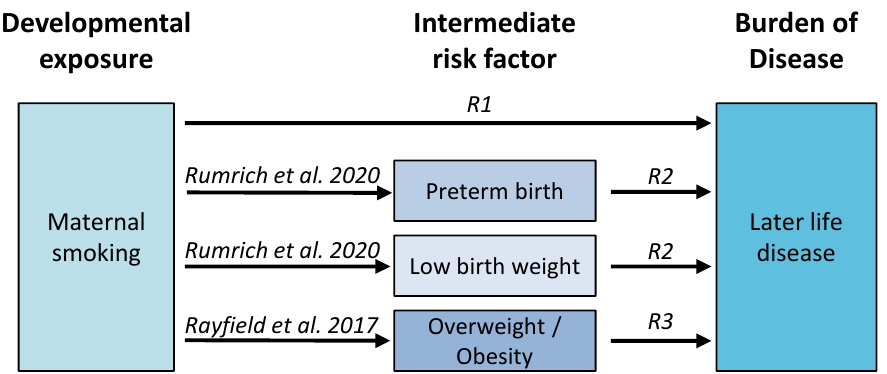
Figure 2. Design of the chained risk model for maternal smoking. Review 1 (R1) identifies later life health outcomes associated directly with maternal smoking and reviews 2–3 (R2, R3) those mediated via the three intermediate factors.